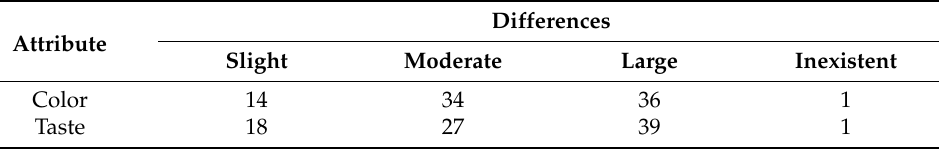
Table 6. Assessment of the color and texture attributes of goat milk yogurt (GMY) and goat colostrum yogurt (FGC) using a triangle test (n = 85